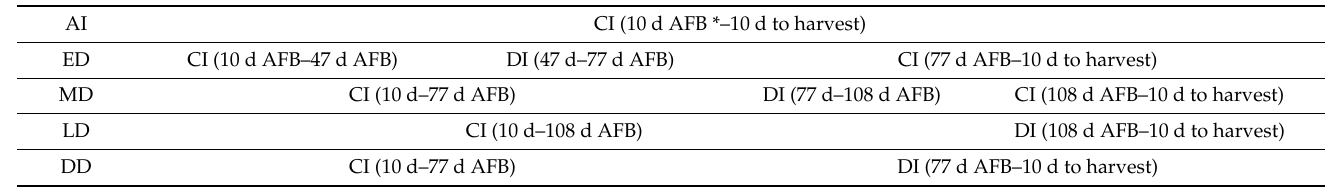
* Abbreviations in the table—d: days; AFB: after full bloom; CI: commercial irrigation; DI: deficit irrigation; AI: adequate irrigation with CI for the whole growth season; ED: early-summer DI; MD: middle-summer DI; LD: later-summer DI; DD: double-period DI, which covers the periods MD and LD. The number of days AFB for harvest were 137 in 2018 and 145 in 2019,